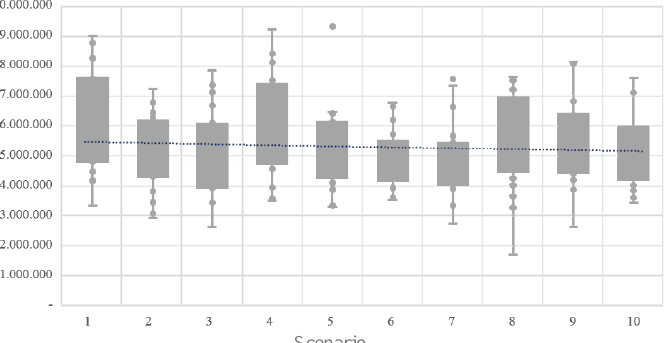
Figure 2. Operating costs ( € ) for each scenario.